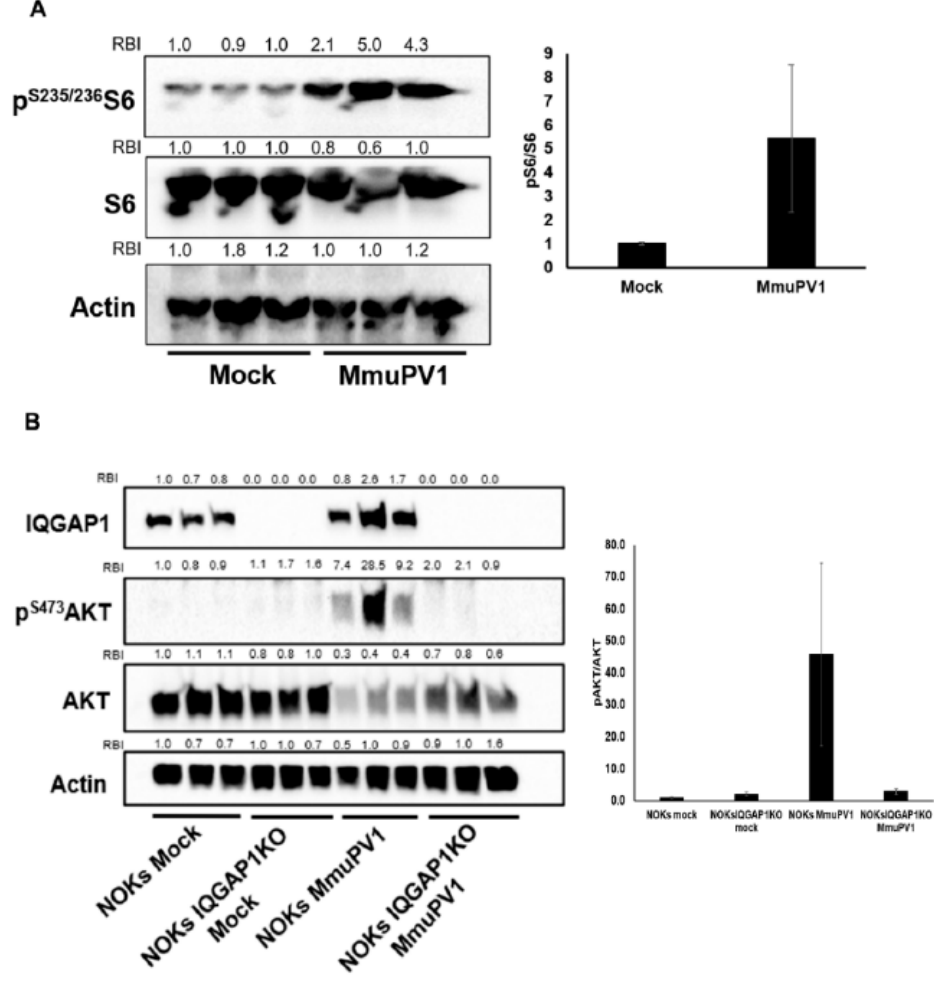
Figure 2. MmuPV1 infection induces PI3K signaling in keratinocytes. ( A ) MmuPV1 infection induces PI3K signaling in primary mouse keratinocytes. Left: immunoblotting detection of S6 activation levels in mock-infected and MmuPV1-infected primary mouse keratinocytes. Relative band intensity (RBI) was calculated by normalizing to the first mock-infected lane from the left. Right: quantification of the band intensity. PI3K signaling level was represented by the ratio of phosphorylated S6 (activated form of S6 protein) over total S6. Statistics: mock vs. MmuPV1, p = 0.069, two-sided t -test. ( B ) MmuPV1 infection induces PI3K signaling in NOKs via an IQGAP1-dependent mechanism. Left: immunoblot detection of AKT activation levels in mock-infected and MmuPV1-infected NOKs and NOKs IQGAP1 KO cells. RBI was calculated by normalizing to the first mock-infected NOKs lane from the left. Right: quantification of band intensity. The PI3K signaling level was represented by the ratio of phosphorylated AKT (activated form of AKT protein) over total AKT. Statistics: NOKs mock vs. NOKs MmuPV1, p = 0.053; NOKs MmuPV1 vs. NOKs IQGAP1 KO MmuPV1, p = 0.06; NOKs IQGAP1KO Mock vs. NOKs IQGAP1KO MmuPV1, p = 0.25, two-sided t -test. Note: all